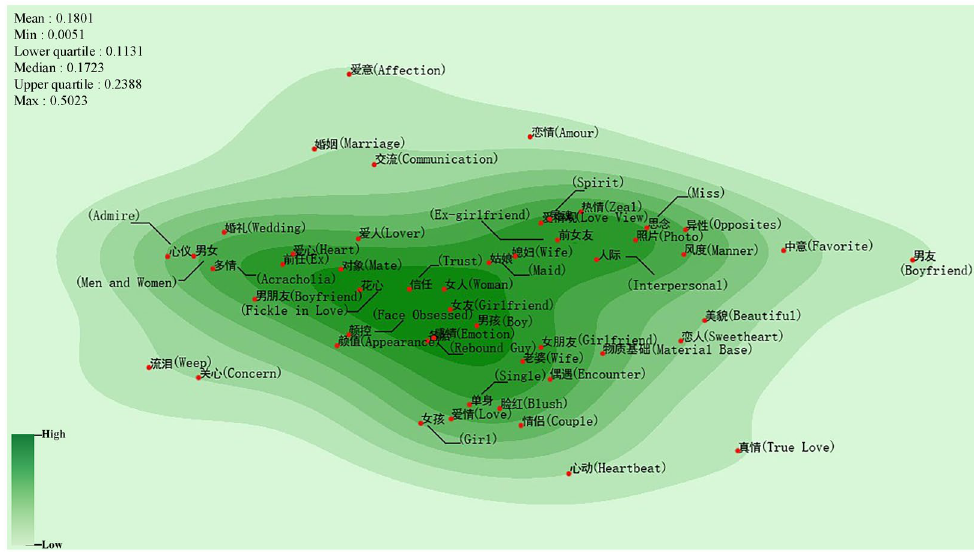
Figure 4. Semantic map of inferiority feelings about love and affection (Drawing with Seaborn 0.8.1 in python 36,37